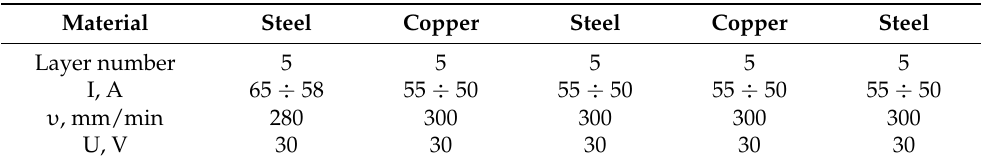
Table 2. The 3D printing parameters for manufacturing the vertical wall from dissimilar materials based on steel and copper.